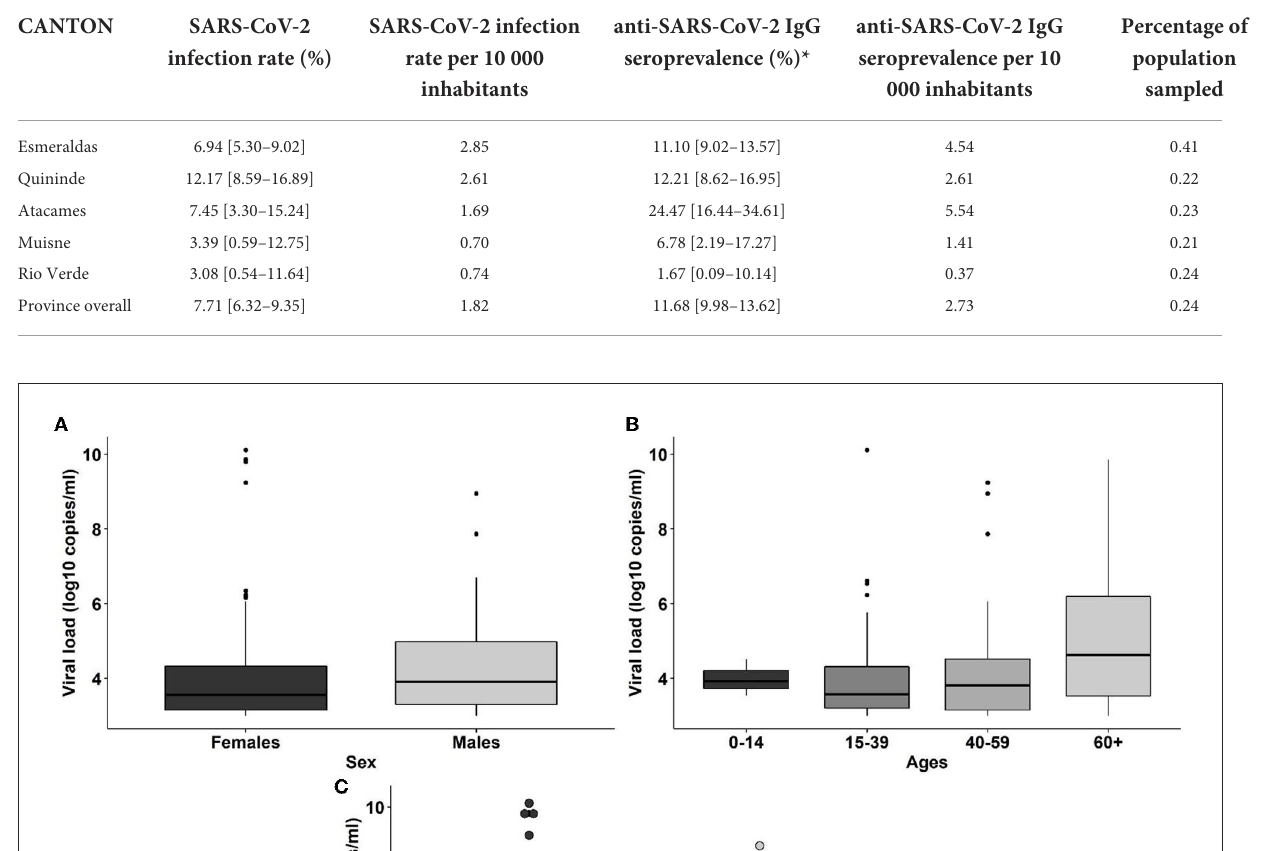
TABLE 1 Severe acute respiratory syndrome coronavirus 2 (SARS-CoV-2) infection rate by RT-qPCR and anti-SARS-CoV-2 Ig G seroprevalence for the 5 cantons included on this surveillance study at Esmeraldas province in October 2020.